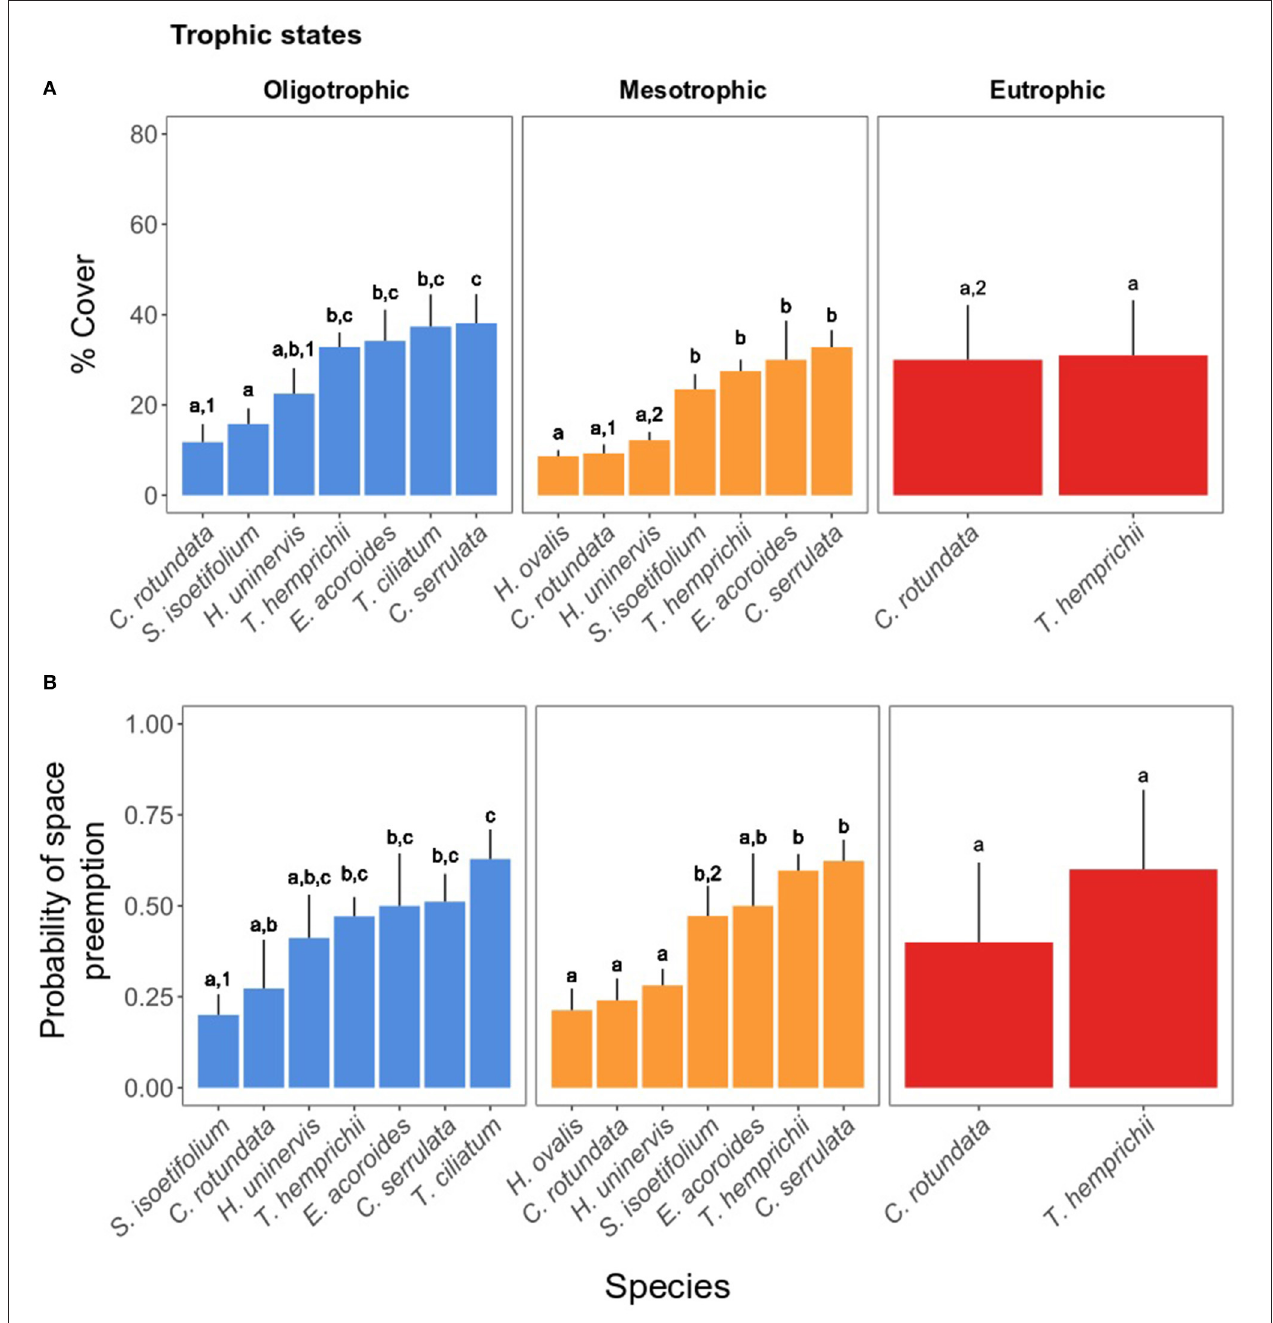
FIGURE 5 | (A) Seagrass cover % of each species in the trophic states. (B) Probability of preemption of the seagrass species in the trophic states. The letters indicate significant differences within the states and among species, whereas the numbers indicate significant differences within a species among states. For the